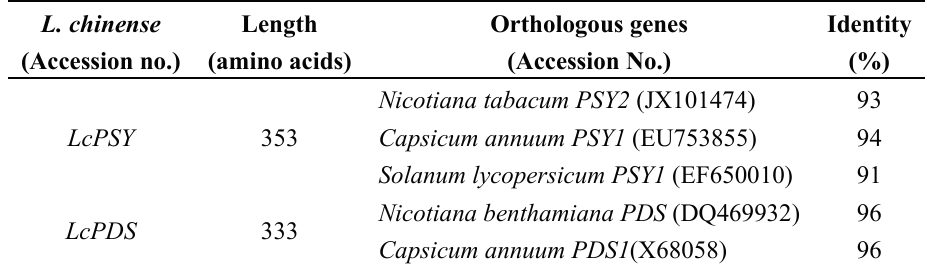
Table 1. Comparisons of carotenoid biosynthetic genes L. chinense with the most orthologous